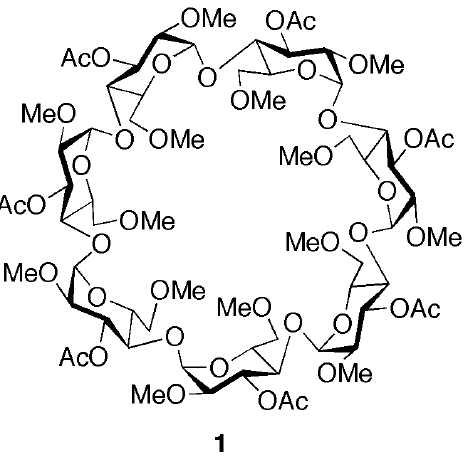
Figure 1 . Structure of heptakis-2,6-di- O -methyl-3- O -acetyl- β -cyclodextrin ( 1